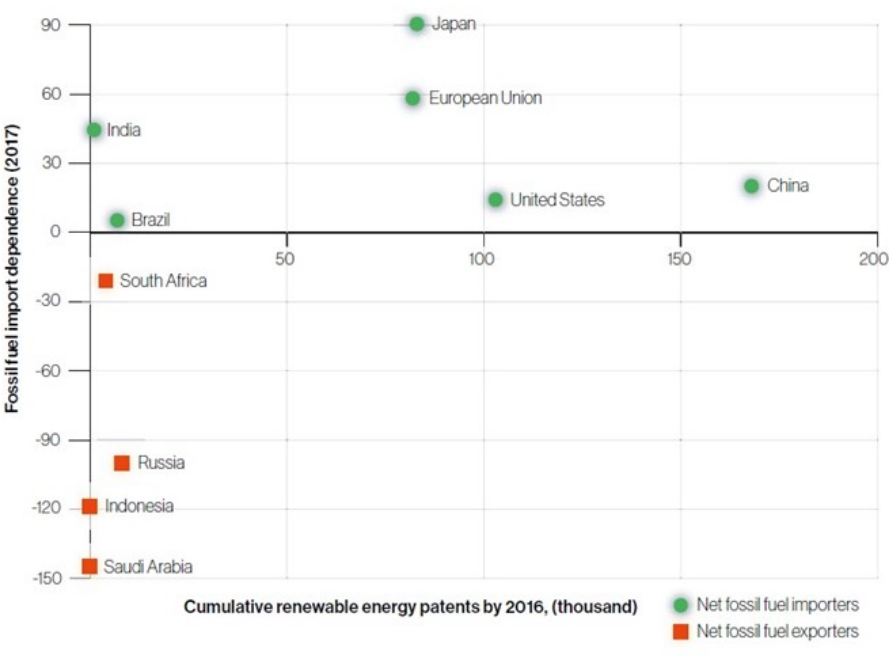
Figure 5. Renewable energy patents in fossil fuel-importing and exporting countries [15].